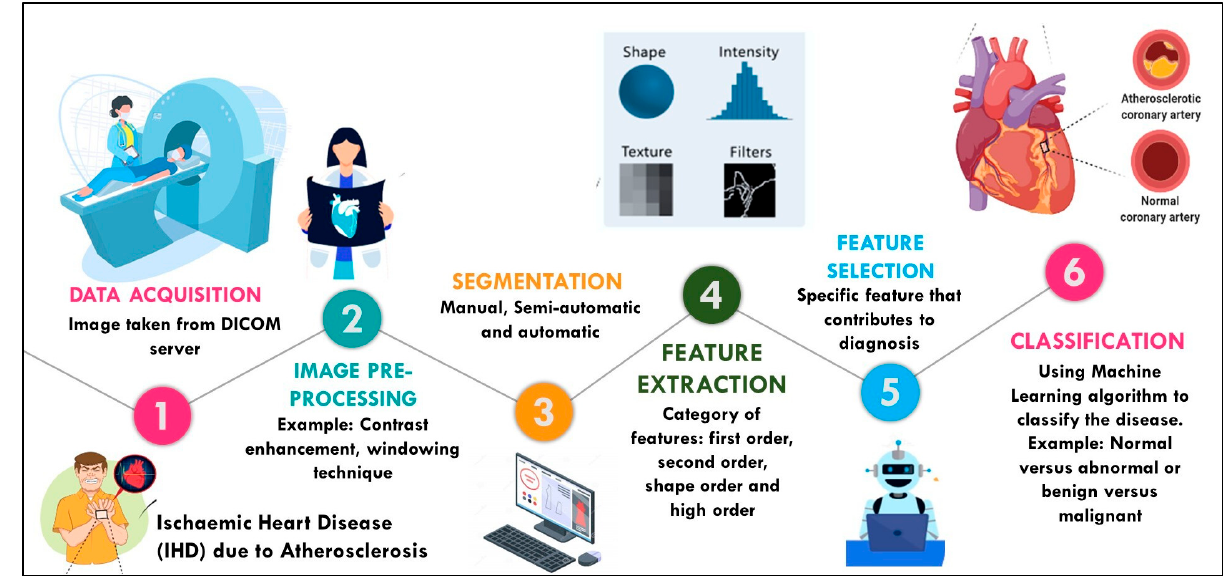
Figure 1. Radiomics